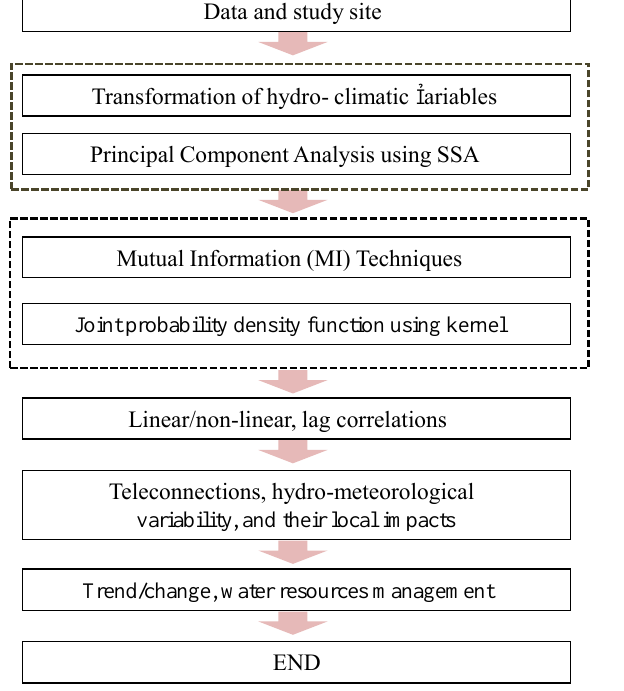
Figure 1. Flow chart of teleconnection based seasonal prediction study between climate indices and hydro-meteorological